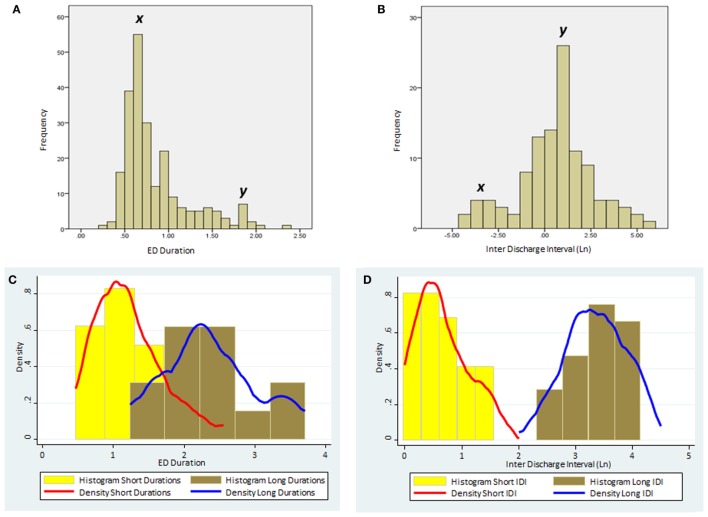
The distribution of ED duration and IDI based on the pooled data from the all 23 subjects. (A) Histogram of ED duration (seconds) based on the raw data. (B) Histogram of the IDI (minutes) based on the raw data. Note the two distinct populations in each histogram with peaks marked as x and y. (C) Histograms and kernel density plots of ED duration predictions jointly for the short and long duration populations detected by the finite mixture modeling. (D) Histograms and kernel density plots of the Ln of the IDI predictions jointly for short and long populations detected by the finite mixture modeling. (Please note that IDIs were logarithmically transformed in the histogram as the original data were skewed.) ED, epileptiform discharge; IDI, interdischarge interval; Ln, Log (natural).